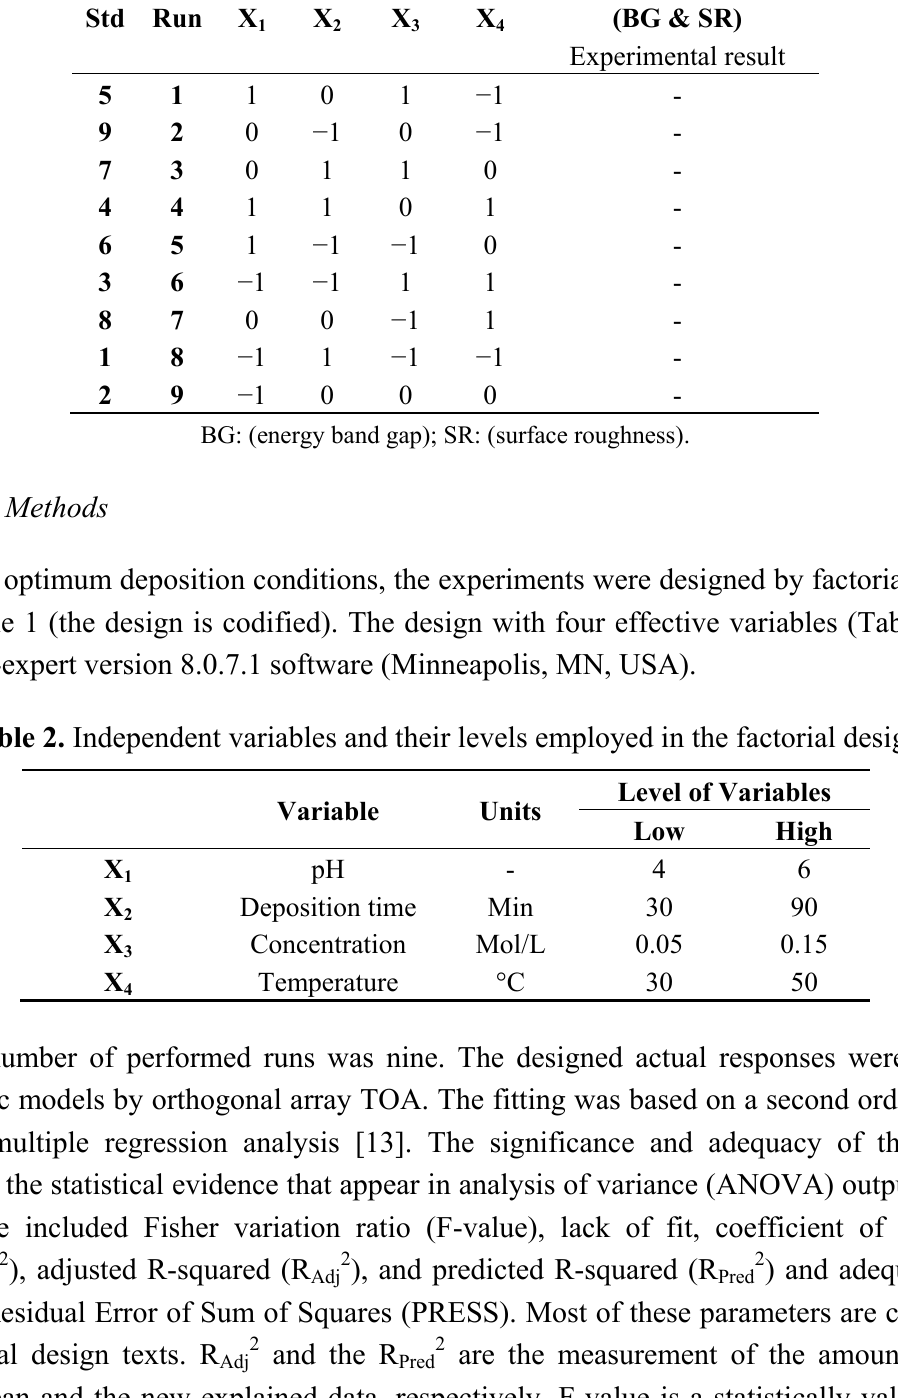
Table 1. Experimental design of SnO